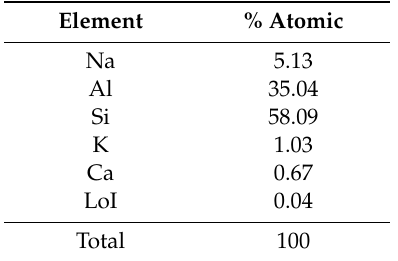
Figure 3. Energy dispersive X-ray spectrum obtained for zeolite Y. The first two un-named peaks represent carbon and gold, as the samples were gold-coated prior to the analysis. The corresponding atomic concentrations are presented in Table 1 below. Table 1. Elemental composition of zeolite Y.